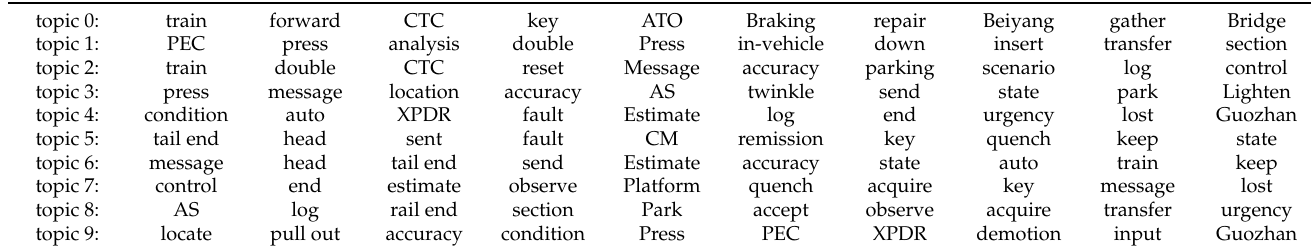
Table 7. Topic analysis of Point mode end change (PEC).